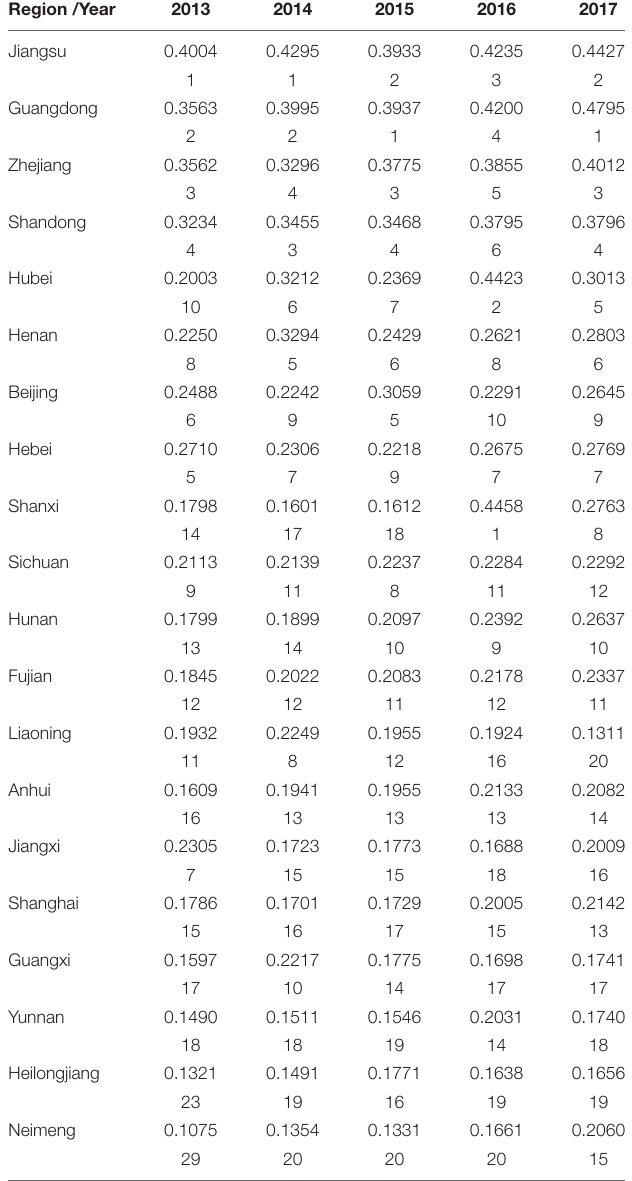
TABLE 2 | Scores and rankings of the resilience of sports development in each region in China. Region